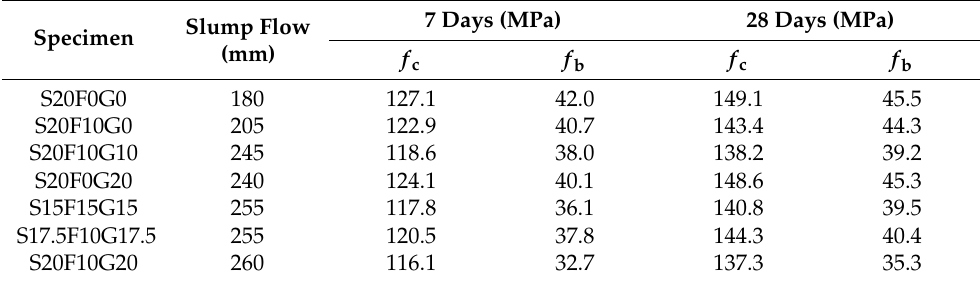
Table 3. Flowability and mechanical properties of EUHPC under standard